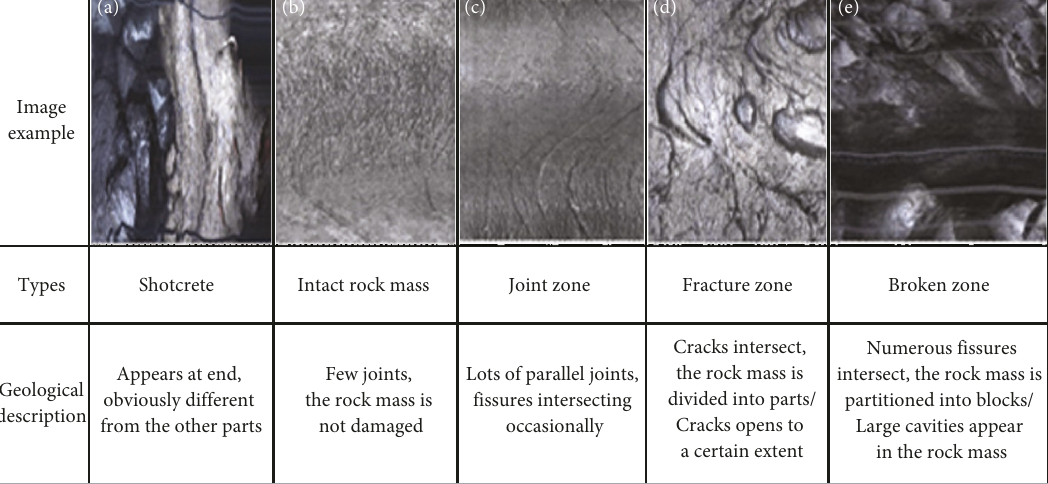
Figure 8: Classification criteria and examples of surrounding rock (a) shotcrete, (b) intact rock mass, (c) joint zone, (d) fracture zone, and (e) broken